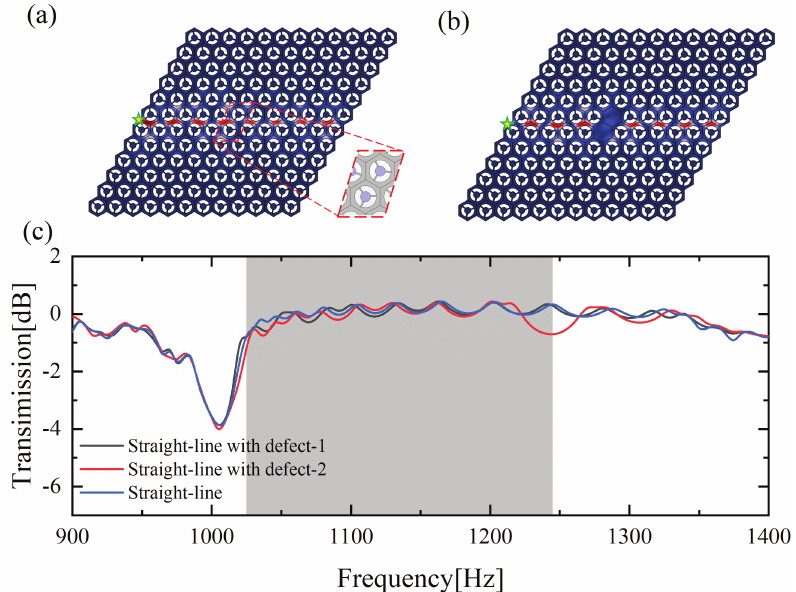
Figure 7. Displacement field intensity distribution and transmission curve under an out-of-plane harmonic excitation of 1133.5 Hz: ( a ) straight-line topological waveguide with disordered elements; ( b ) straight-line topological waveguide with defect elements; ( c ) transmission curve of these two structures of ( a , b